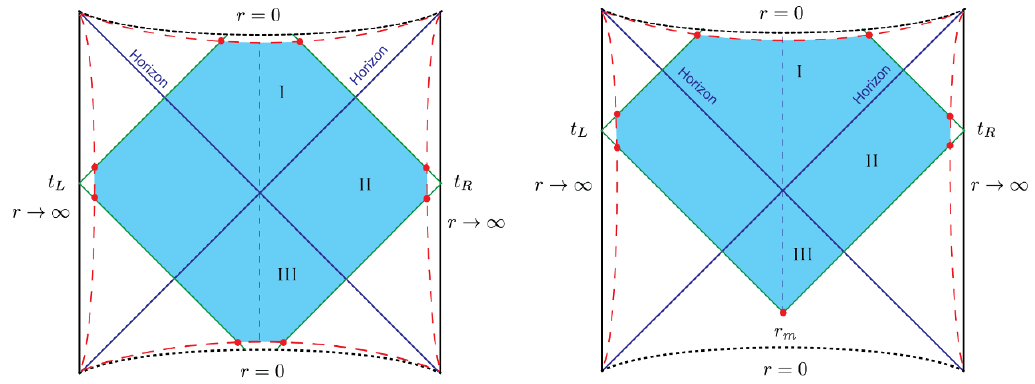
Figure 1 . Penrose diagram of the WDW patch of an eternal AdS black hole, moving forward in time in a symmetric way ( t L = t R